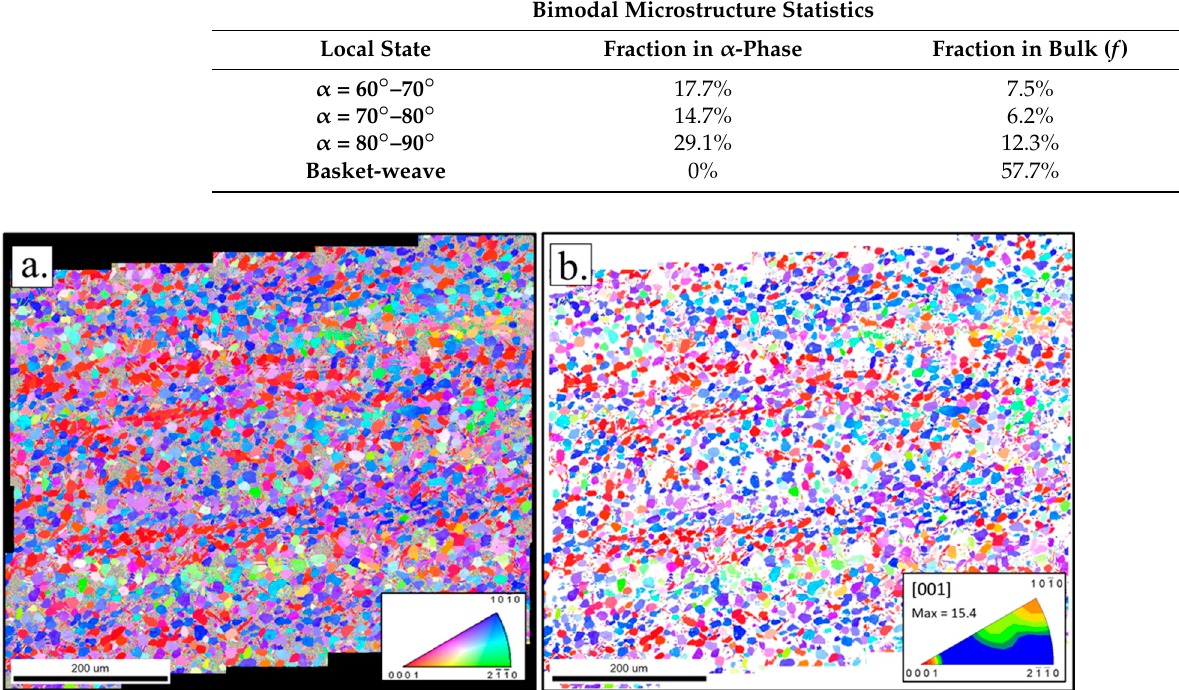
Figure 3. ( a ) Compilation of 20 EBSD scans from a Ti6242 bimodal microstructure with primary α and basket-weave grains. Areas with low image quality correspond to basket-weave grains. ( b ) Inverse Pole Figure map of the primary a grains only, with a harmonic tex. Table 1. Fraction corresponding to each of the binned regions of the primary a phase, and the cor- responding volume fractions of all constituents in the bulk microstructure.